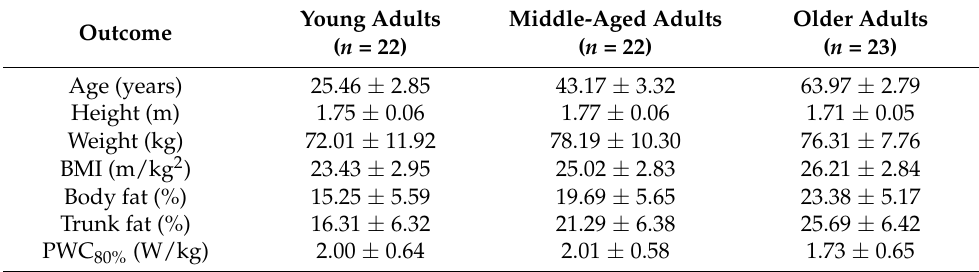
Table 1. Descriptive characteristics of the three age groups.